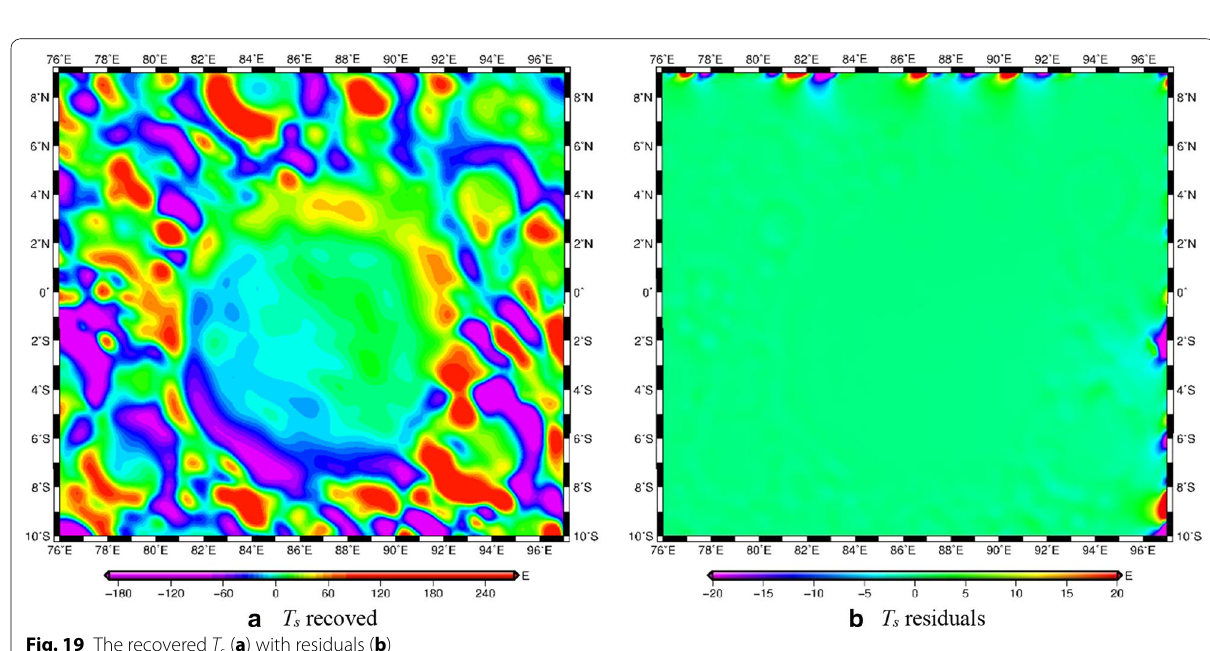
Fig. 19 The recovered T s ( a ) with residuals ( b